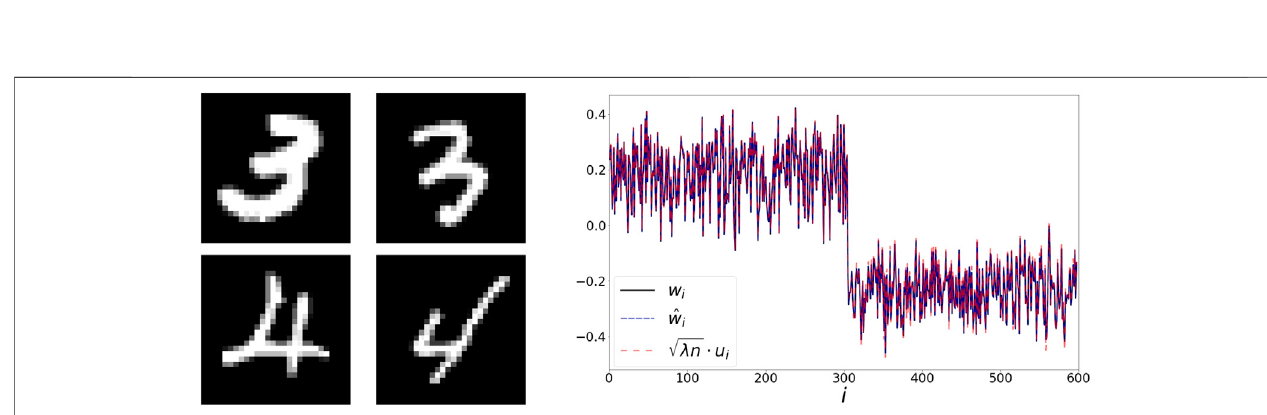
(cid:12)(cid:12)(cid:12)(cid:12) √ λ nu , the leading eigenvector of P − 1